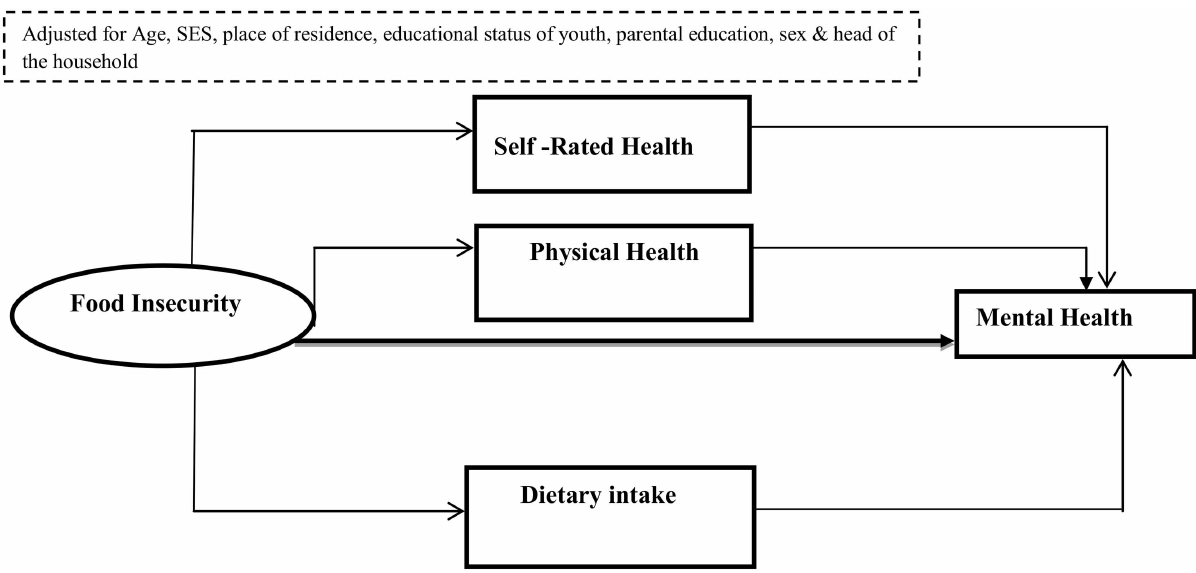
Fig 1. Conceptual framework showing the link between food insecurity and youth common mental disorders, JLFSY, 2015.